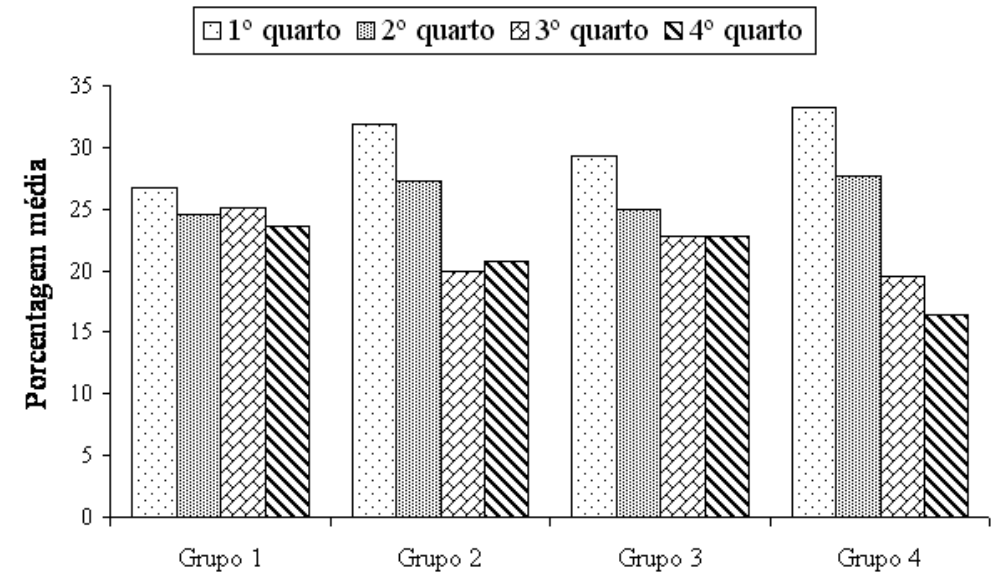
Figura 2 . Porcentagem média de erros, em relação ao número total de tentativas erradas, nos quatro quartos do Teste de